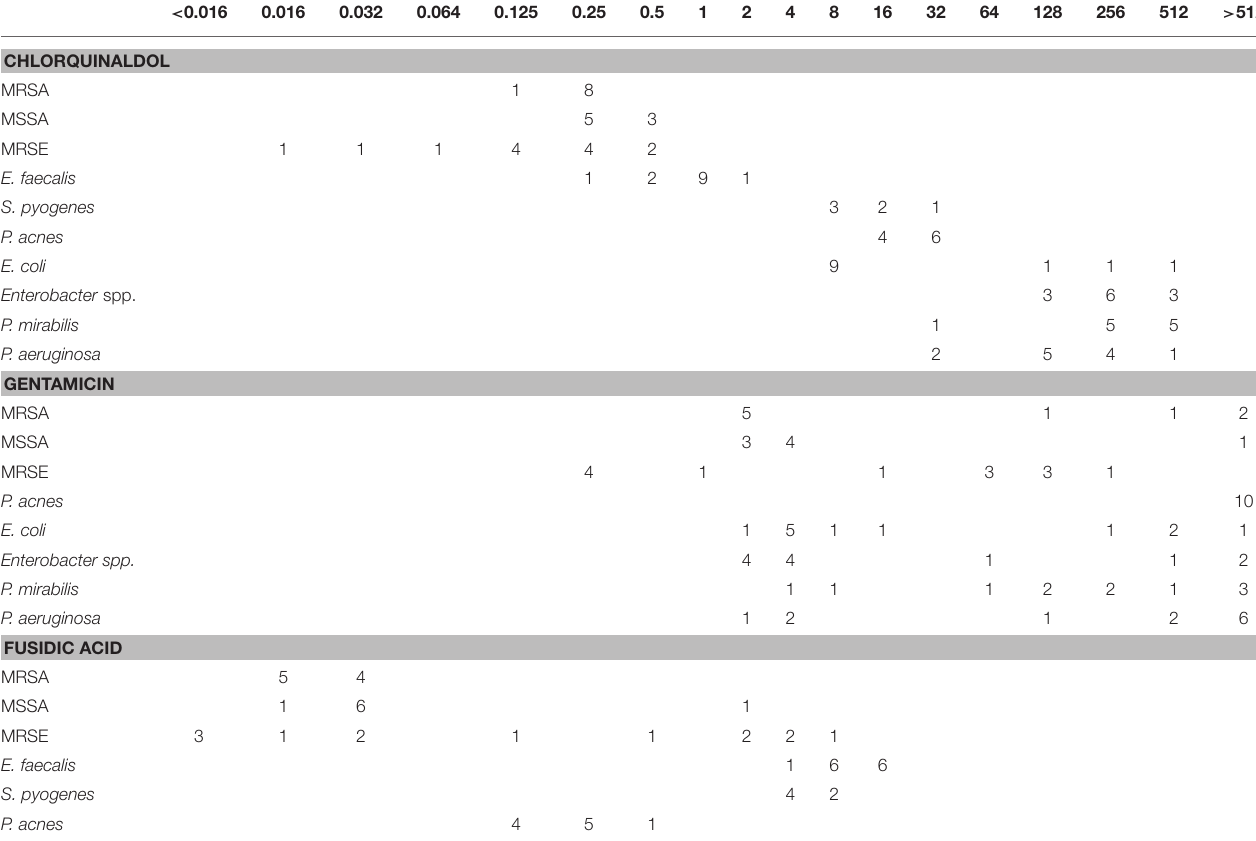
TABLE 3 | MIC distributions